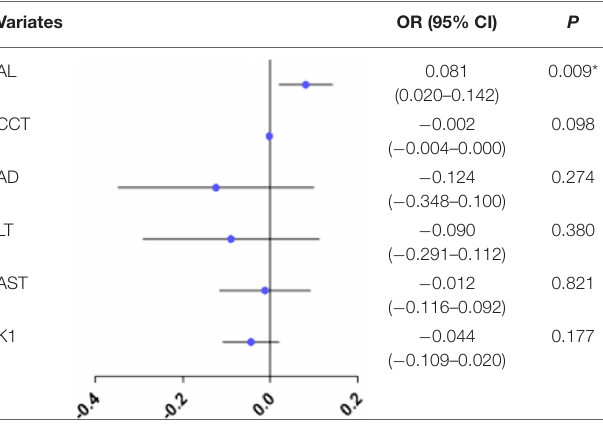
TABLE 4 | Relationship between RPRE and ocular biological parameters at 25–30 ◦ eccentricity.